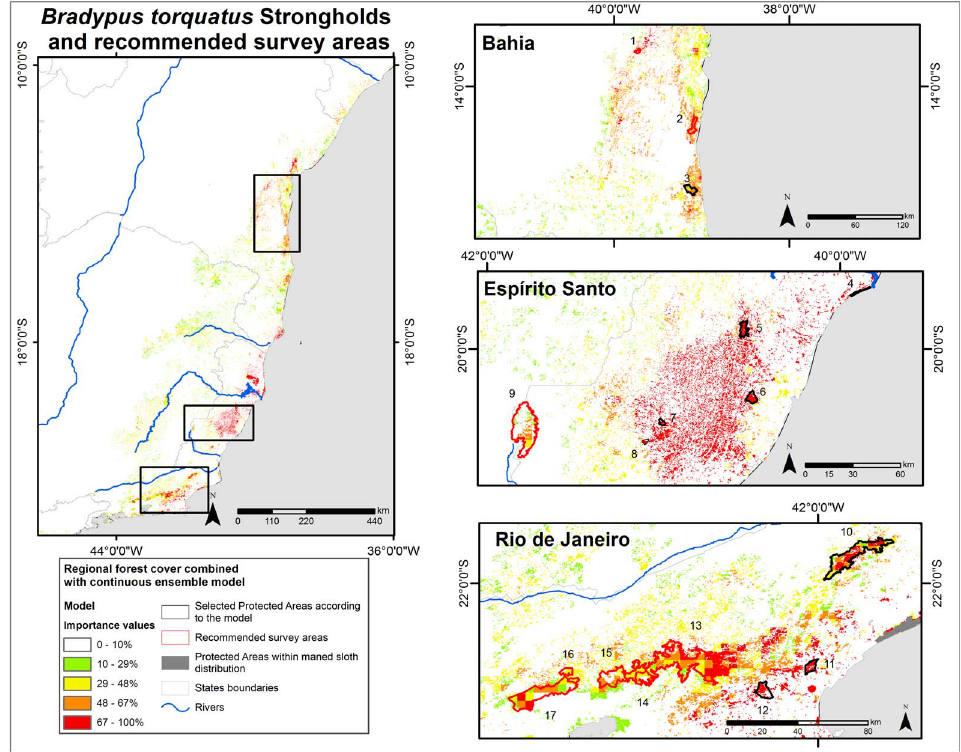
Figure 6. Maned sloth’s ( Bradypustorquatus ) strongholds and recommended survey areas. Current fragments of the Atlantic Forest, combined with the potential geographic distribution modeling and the federal and state strictly protected areas. We used each fragment larger